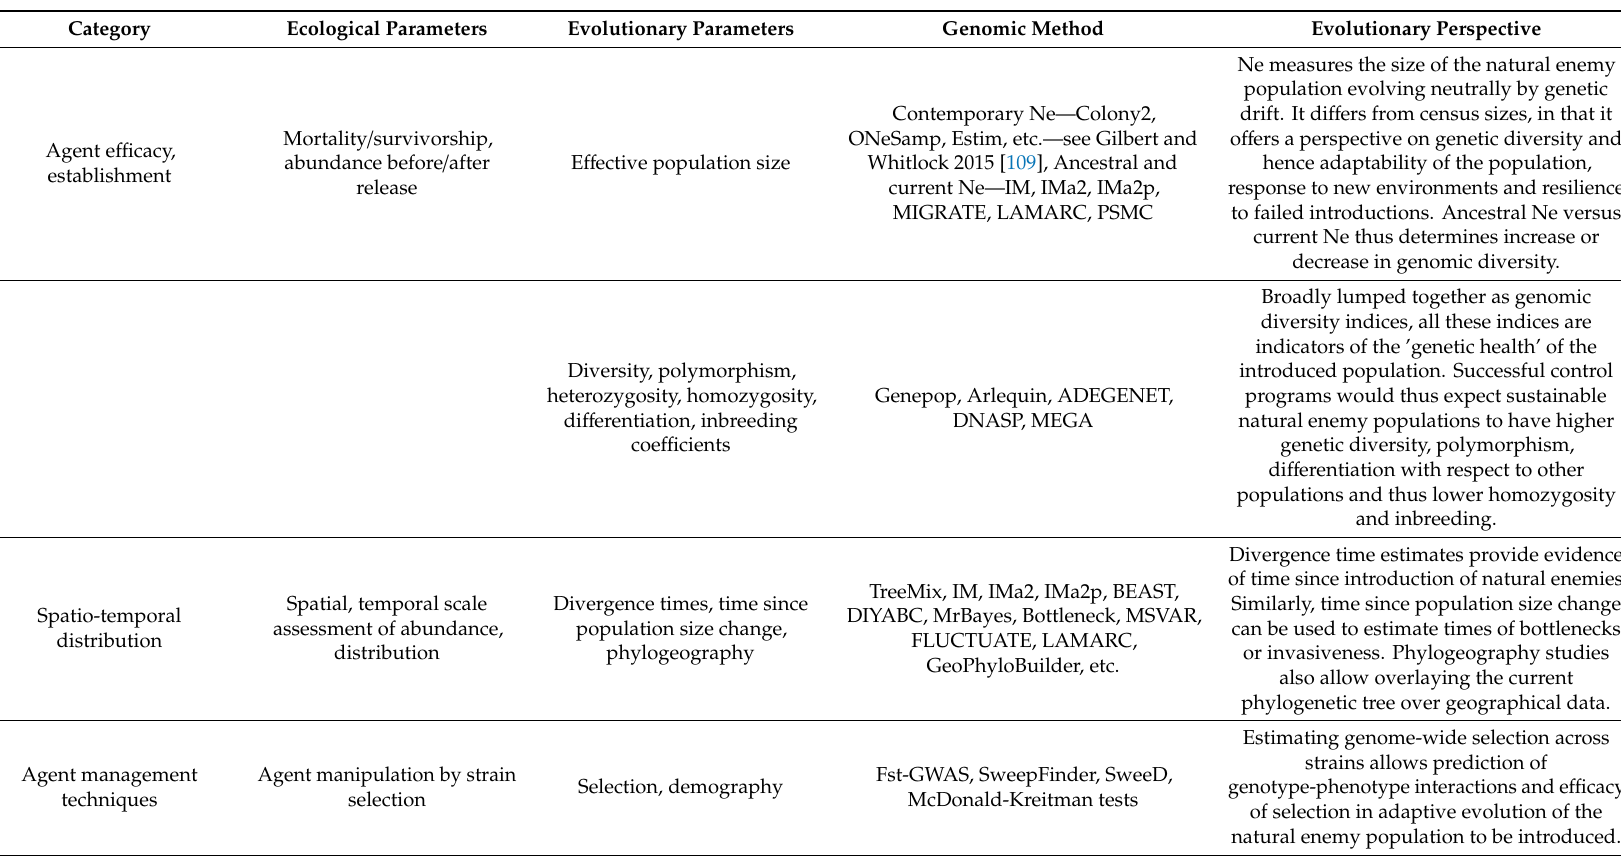
Table 2. Indicators of success of biological control programs and how we can measure / estimate these using population genomic methods. All methods listed either utilize microsatellite or Short Tandem Repeat (STR) markers, Single Nucleotide Polymorphisms (SNPs) or haplotype data generated from common genotyping and sequencing